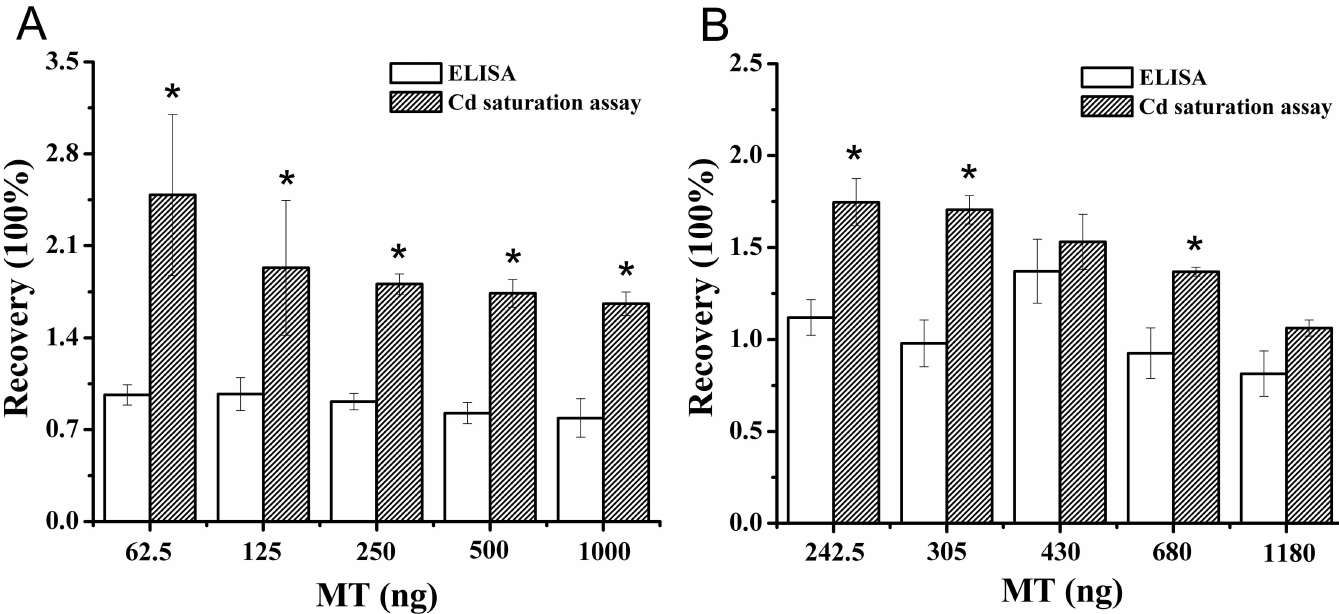
Fig 5. Recovery of purified MT (A) and MT added to crab hepatopancreas cytosol (B) as determined with the ELISA and Cd saturation assay. Data are expressedas mean ± standard deviation(n = 5). Comparison betweenthe ELISA and Cd saturation assay groupsis notified as * p < 0.05.